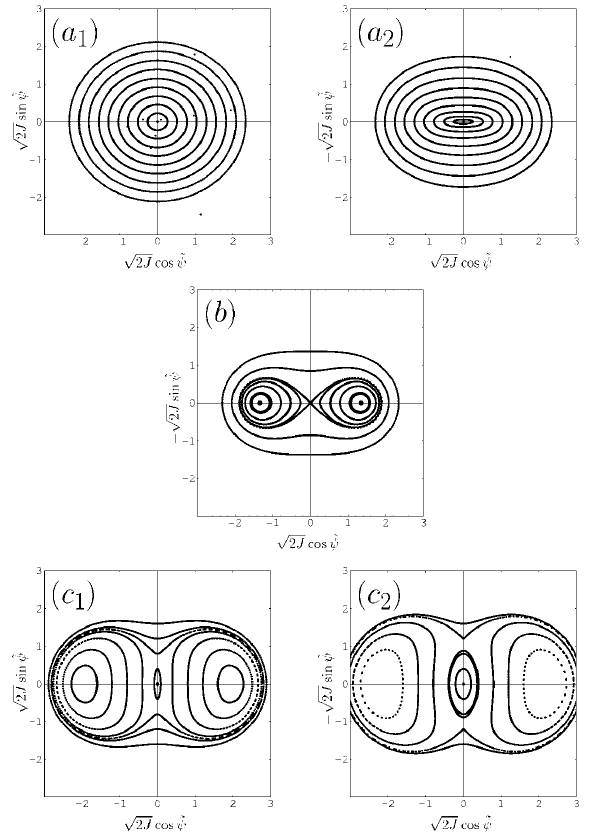
FIG. 1. Simulated particle trajectories in a surface of a section of the Hamiltonian (3) with the parameters n s (cid:1) 0.0005 and e (cid:1) 0.45 . In (a1) the modulation tune n m (cid:1) 0.0018 is above and far away from the parametric resonance interval, in (a2) it is still above but with n m (cid:1) 0.0011 close to this interval. (b) shows the situation with n m (cid:1) 0.001 , when the parametric resonance is excited. (c1) and (c2) depict the cases with n m (cid:1) 0.000 87 and n m (cid:1) 0.0008 , respectively, when the modulation tune is below the parametric resonance and either close or far away from that